Question: According to the figure, is the described quantity increasing or decreasing?
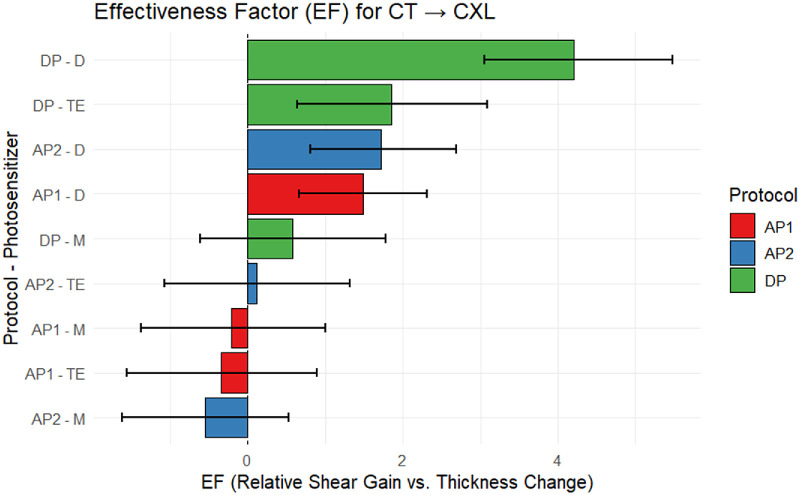
Answer: increasing